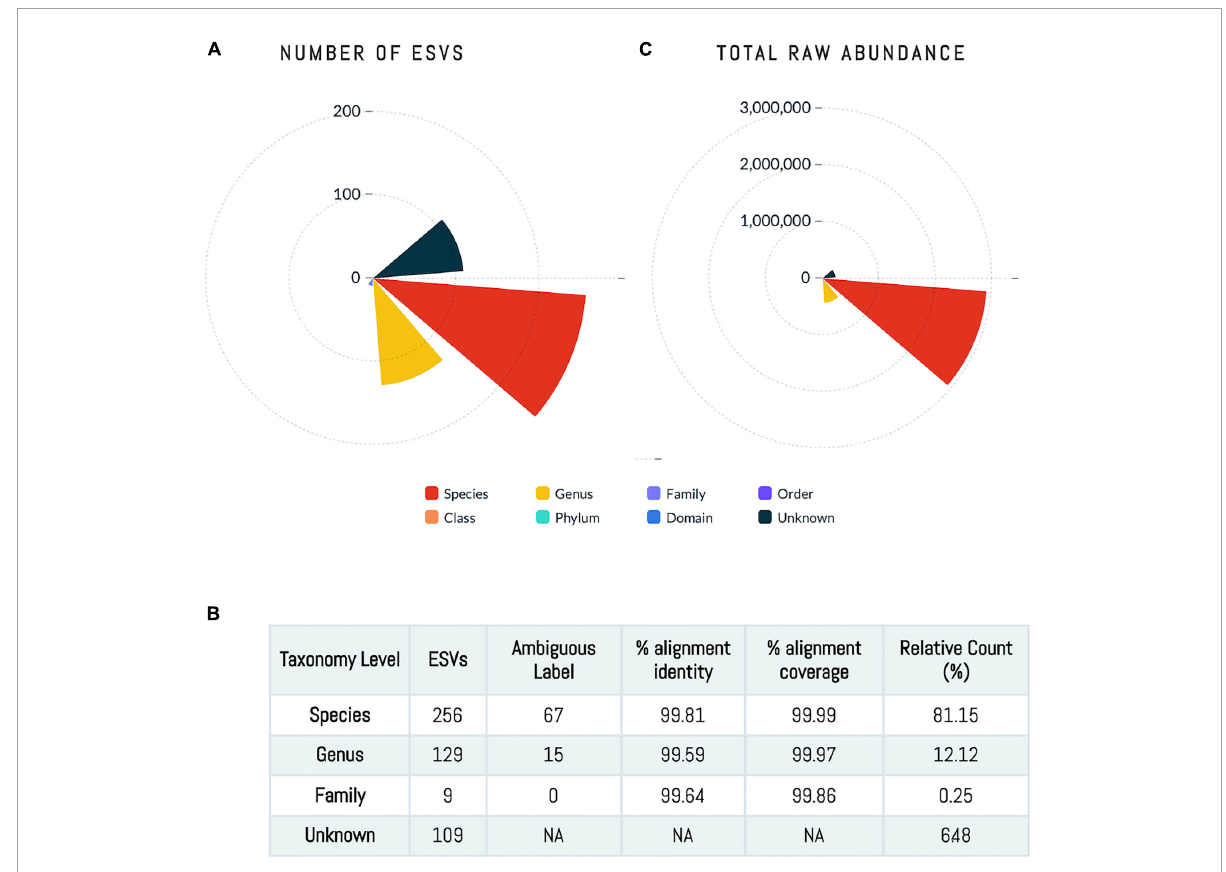
FIGURE1 Human milk microbiome community. (A,C) The number of ESVs at different taxonomy level showing that sequences annotated at species level account for 81% of the ESVs. (B) The total abundance at each taxonomy level.